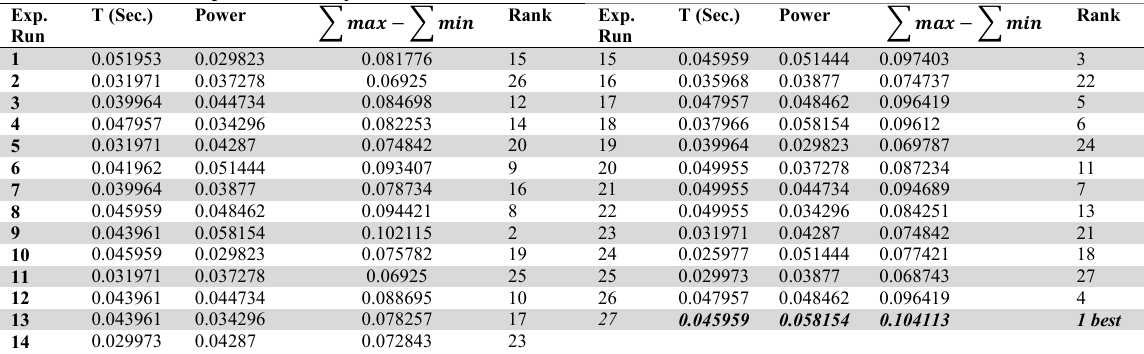
Results of multi objective analysis Exp.